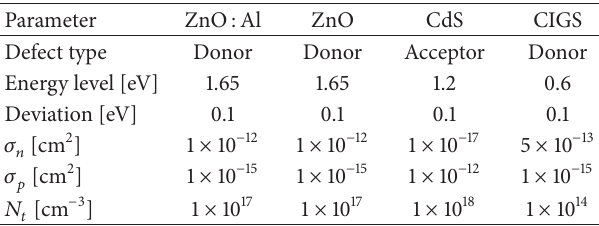
Table 2: Simulation material Gaussian defect for the CIGS solar layers.